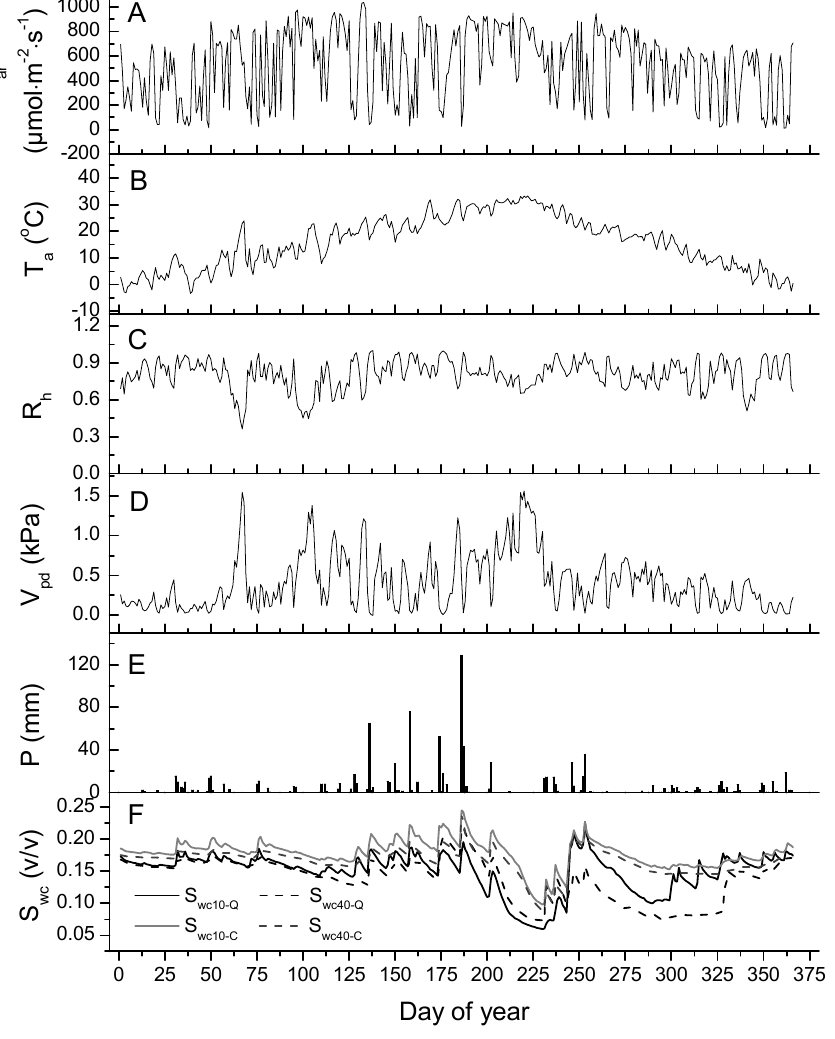
Figure 3. Seasonal course of daily maximum photosynthetically-active radiation (P ar ) ( A ), daily mean air temperature (T a ) ( B ), mean air relative humidity (R h ) ( C ), mean vapor pressure deficit (V pd ) ( D ), daily sum of precipitation (P) ( E ) and daily mean soil water content (S wc ) ( F ) between 9 September 2012 and 8 August 2013.